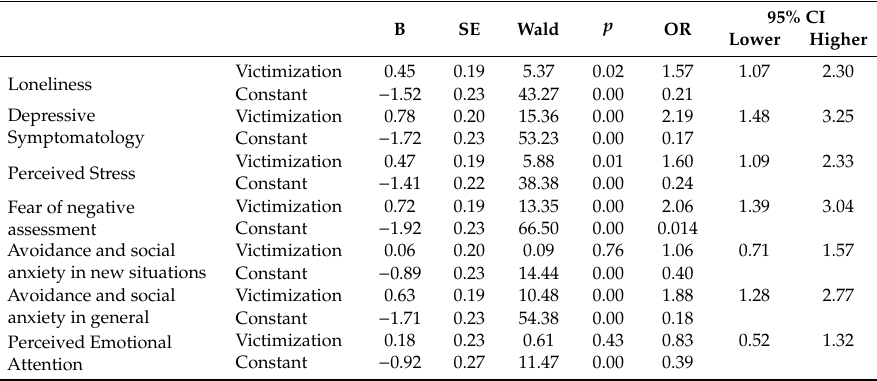
Table 4. Logistic regression with cyberaggression as a predictor of high